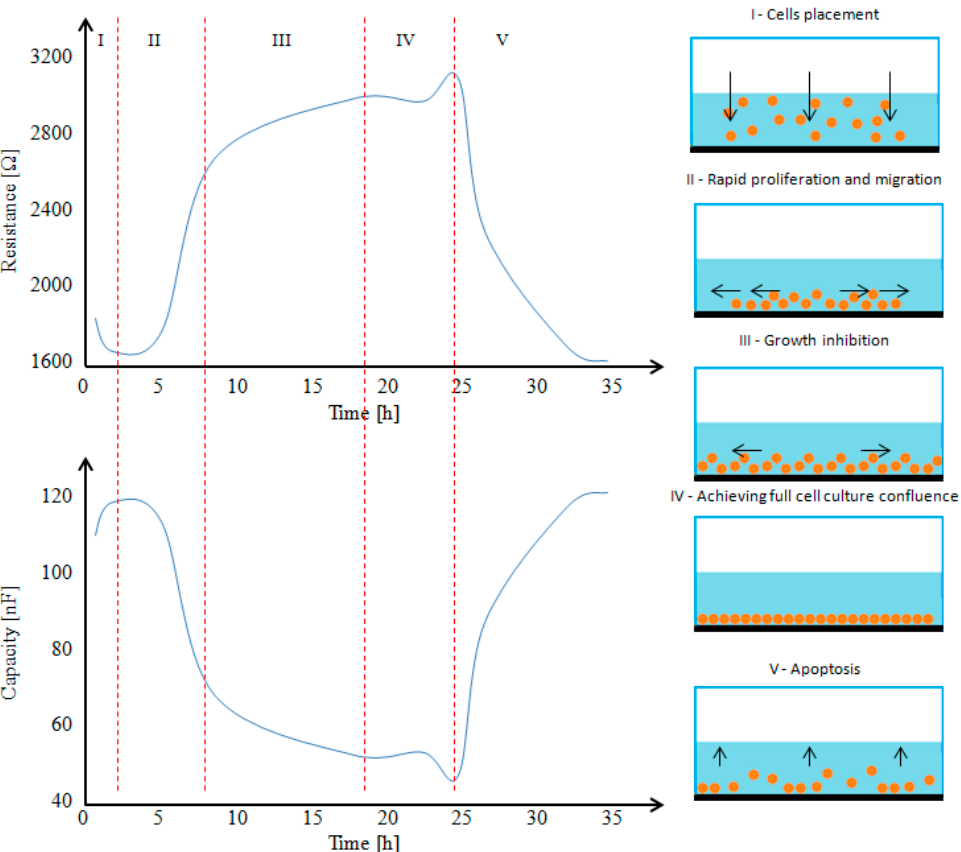
Figure 2. The expected nature of changes in the measured resistance for 4 kHz and capacitance for 64 kHz. As the measured value of the resistance increases, the value of the measured capacitance value decreases. In the first phase, cells are placed in the well with the medium (arrows indicate cell movement) ( I ). Then, cells at a dynamic pace migrate along the surface of the bottom of the container, multiplying ( II ). After this stage, cell growth ( III ) slows down, after which the cells occupy the entire bottom of the container, reaching full confluence and forming a monolayer ( IV ). The last stage of the life cycle of cells is their death and loss of contact with the substrate ( V ).